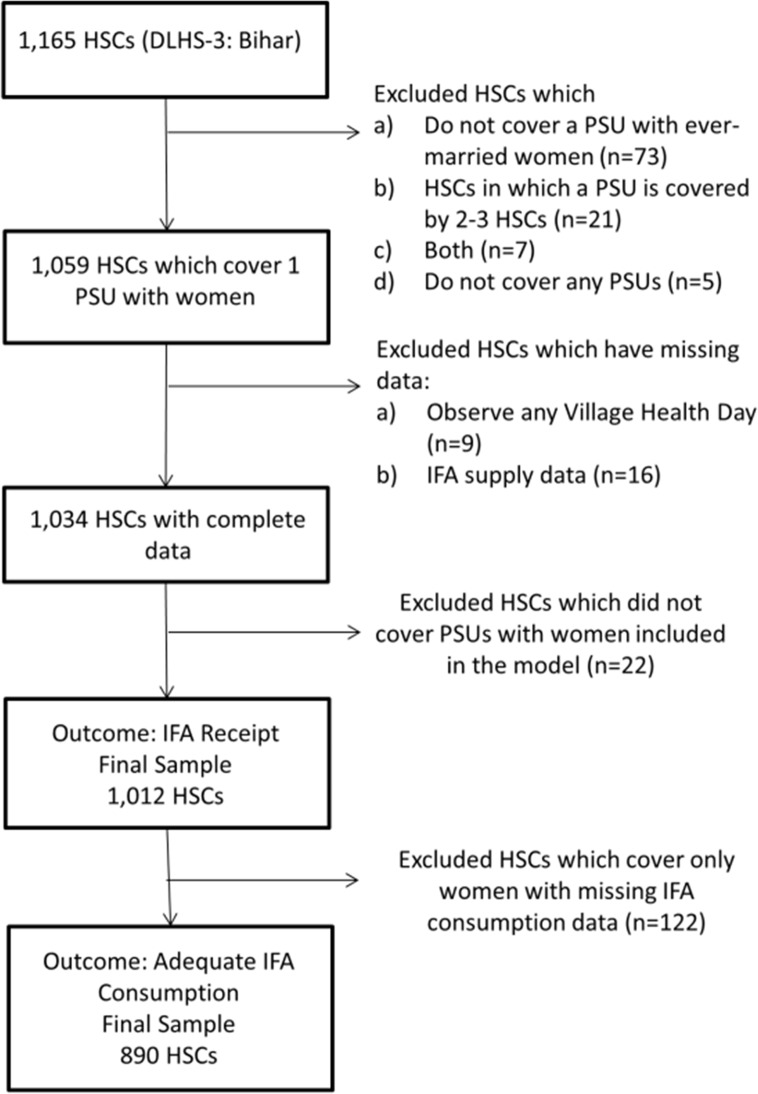
Flowchart of Health Sub-Center exclusions and final sample.Flowchart of exclusions and final sample of health sub-centers surveyed in Bihar through DLHS-3. HSC: Health Sub-Center; DLHS: District Level Household Survey; PSU: Primary Sampling Unit; IFA: iron and folic acid tablets or syrup.